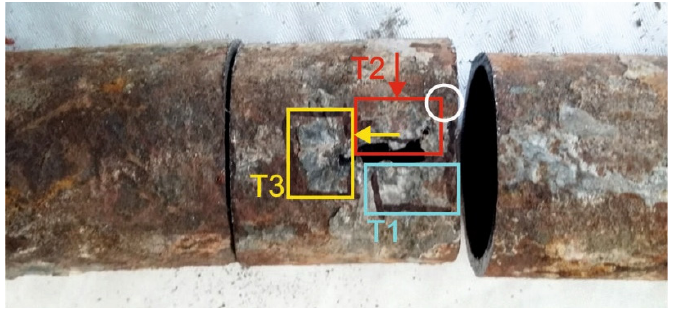
Figure 10. Sampling points T2, T3 with observed areas (indicated by arrows). On sample T1, the observed area was parallel with the outer surface of the tube.